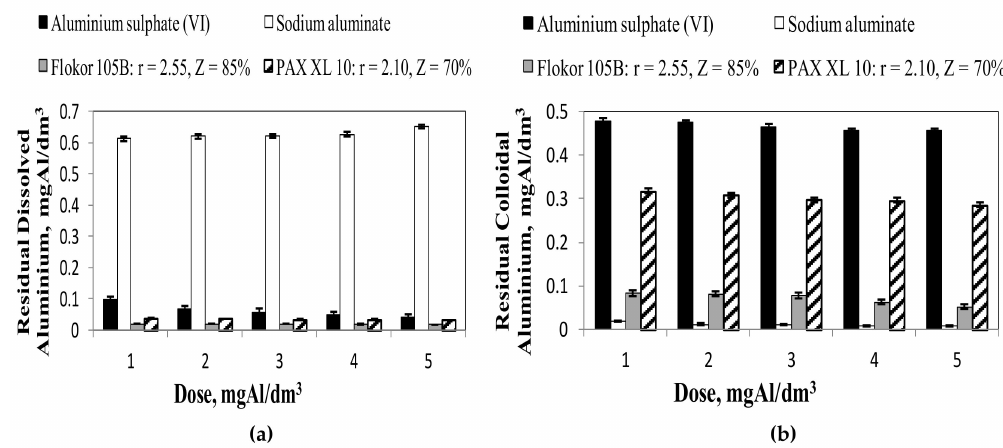
Figure 4. E ff ect of the type and dose of coagulants on the concentration of residual aluminium in dissolved ( a ) and colloidal ( b ) form in purified